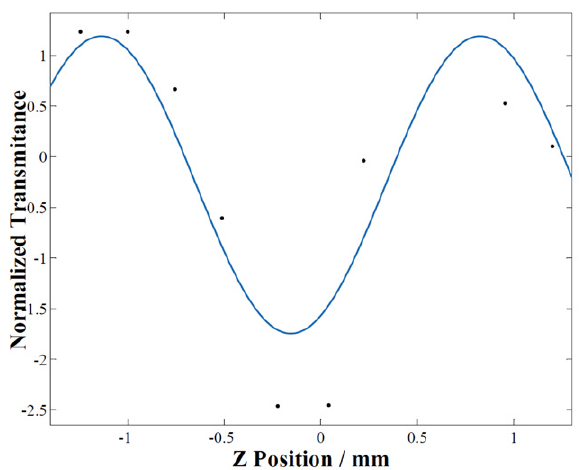
Figure 4. Open aperture Z-Scan data for 4-(4,5-Diphenyl- 1H-imi- dazole-2-yl) phenol solution.